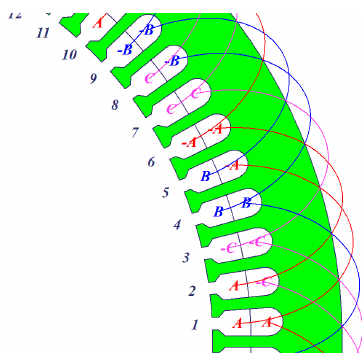
Figure 9. Schematic diagram of winding configuration.